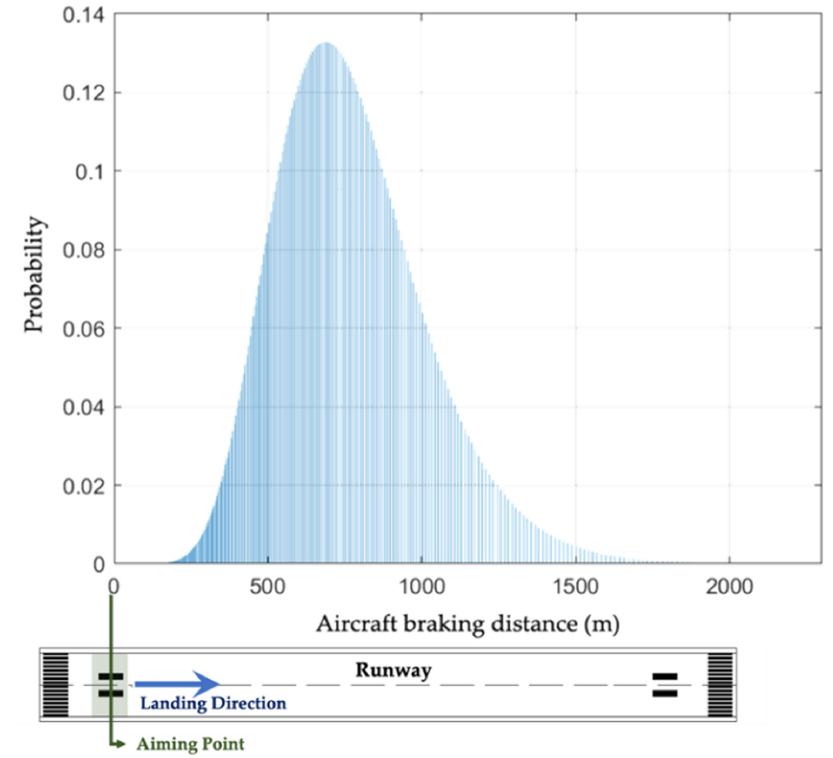
Figure 6. Probability distribution of the braking distances of Airbus 300–600, projected on a 2000 m runway.